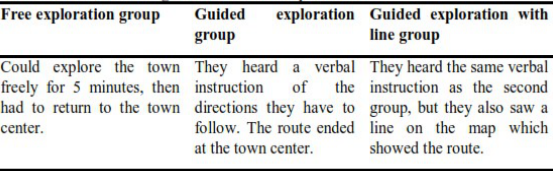
Table 1. The three groups of participants